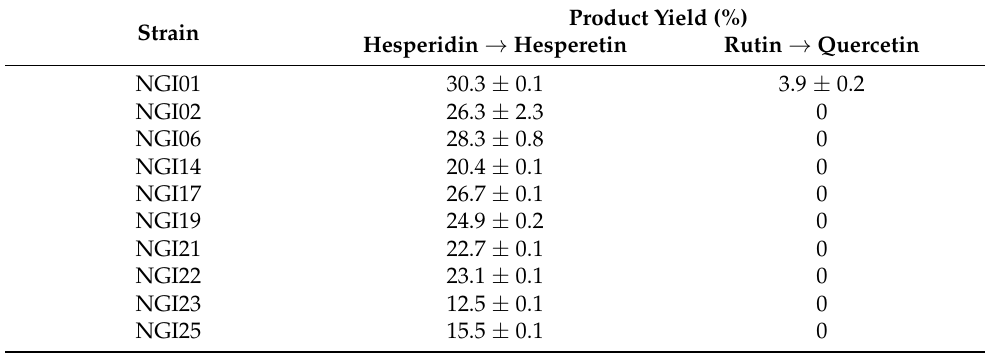
Table 2. Biotransformation of hesperidin and rutin by 10 LAB strains isolated form